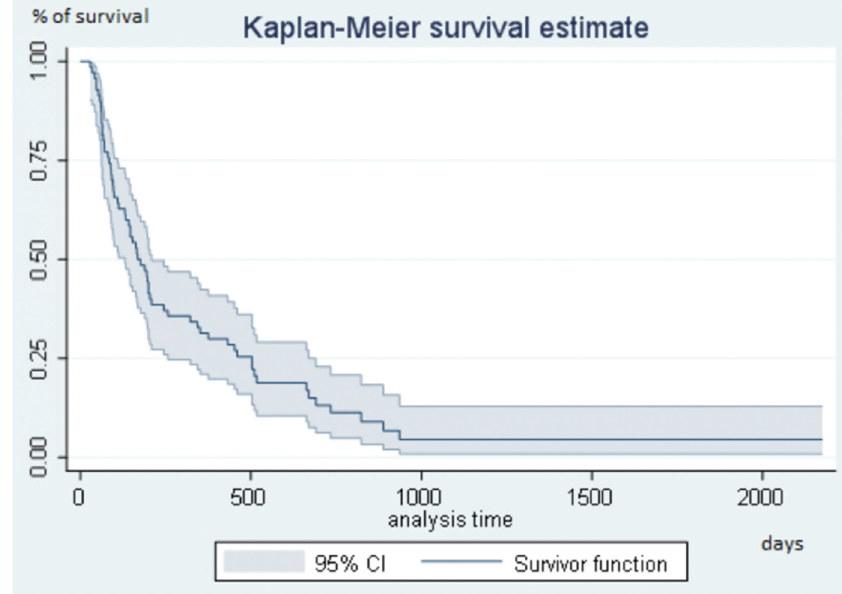
Figure 2. Progression-free survival in the overall study population.